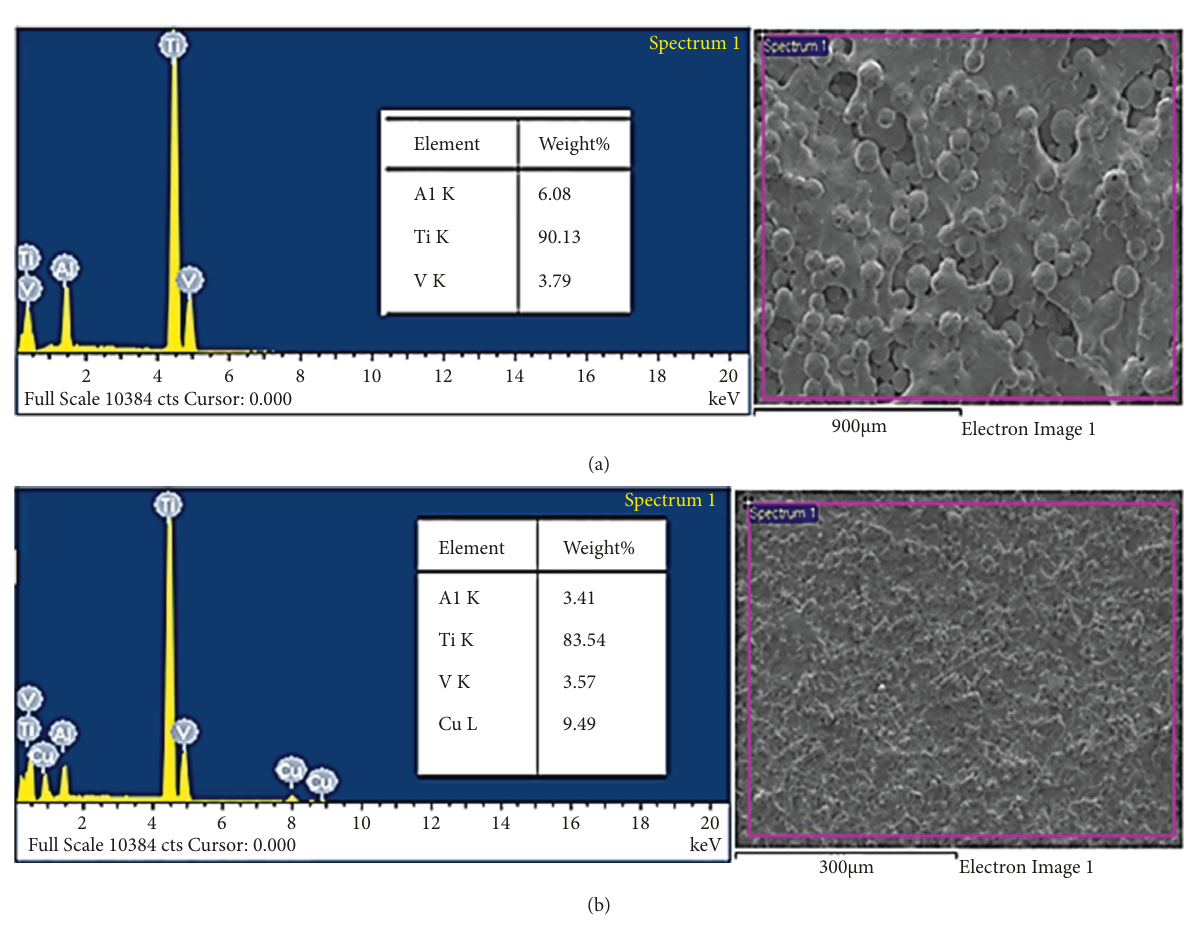
Figure 10: Chemical composition of supported surface after removing the support: (a) manually and (b) by wire